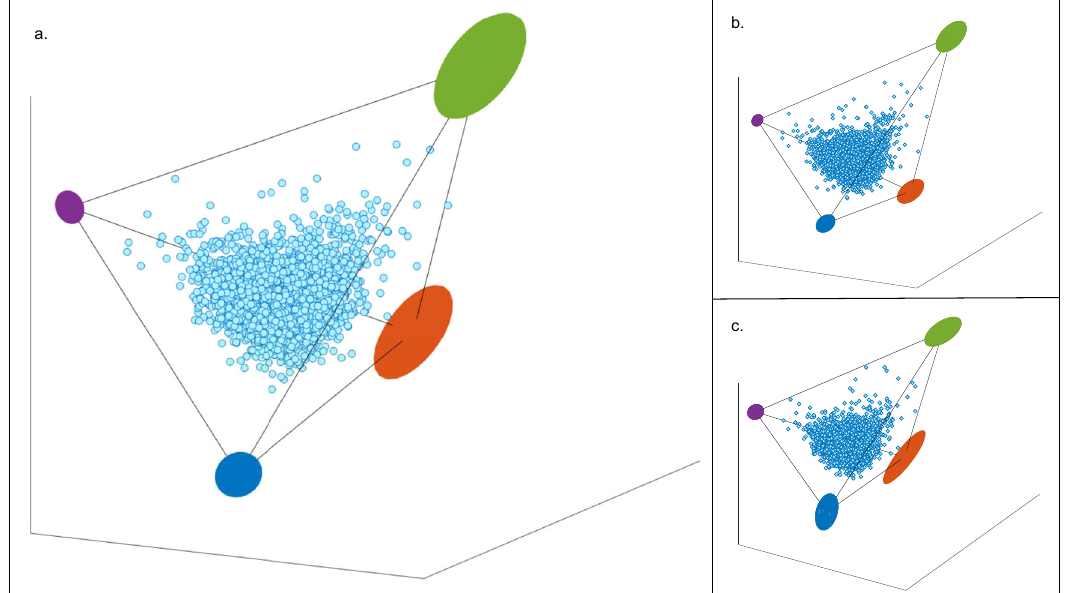
Fig. 2 The clinical labs dataset falls on a signi fi cant tetrahedron ( t -test P -value < 0.001). a The dataset is composed of n = 3094 participants and 67 blood measurements, displayed on the fi rst 3 PCs space (light blue dots). The colored ellipses designate the archetypes ’ possible positions with error after 1000 times of bootstrapping. b , c The tetrahedron is robust to data selection. The participants in the cohort have multiple visits (between 1 – 8). To test the robustness of the tetrahedron, we randomly selected one visit per participant and constructed different data sets. Then, for every data selection we ran the ParTI analysis and found that for different data selections we receive signi fi cant tetrahedrons ( t -test P -value <0.05). Out of 7 data selections 4 were signi fi cant, 3 runs had a t -test P -value < 0.001 (two of them are shown here in b and c ), and the rest had a t -test P -value = 0.04, 0.06, 0.07, 0.28 (see